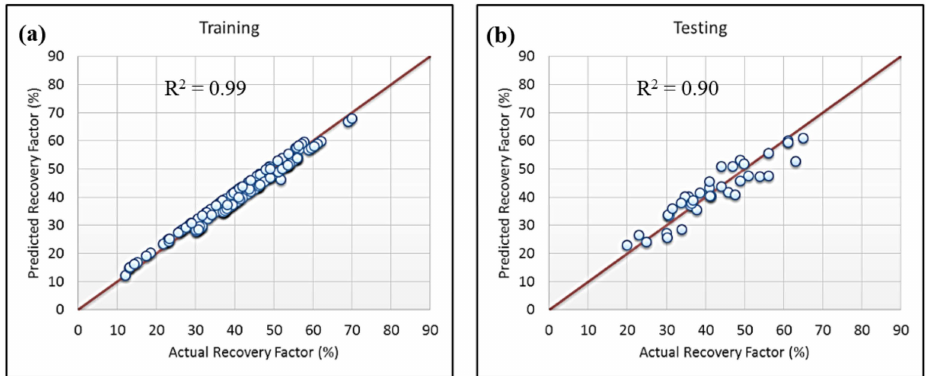
Figure 5. Predicted vs. actual recovery factor based on the support vector machine (SVM) model ( a ) training dataset, ( b ) testing dataset.